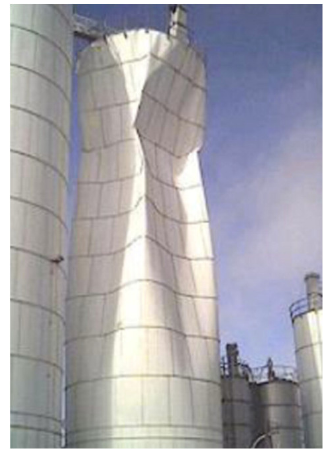
Figure 7. Extreme damage in grain silo caused by asymmetric flow pattern. Source: [29].